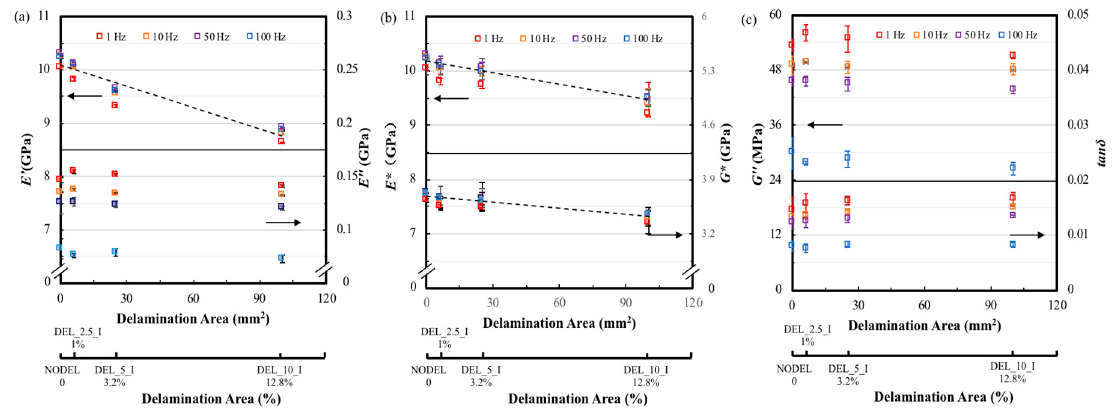
Figure 8. The dynamic mechanical properties of FFRP with different delamination areas tested at 25°C, frequencies of 1, 10, 50 and 100 Hz, amplitude of 10 µm. Variation of ( a ) E’ and E’’ , ( b ) E* and G* and ( c ) tan δ with delamination areas. Materials 2019 , 12 , x FOR PEER REVIEW 10 of 15